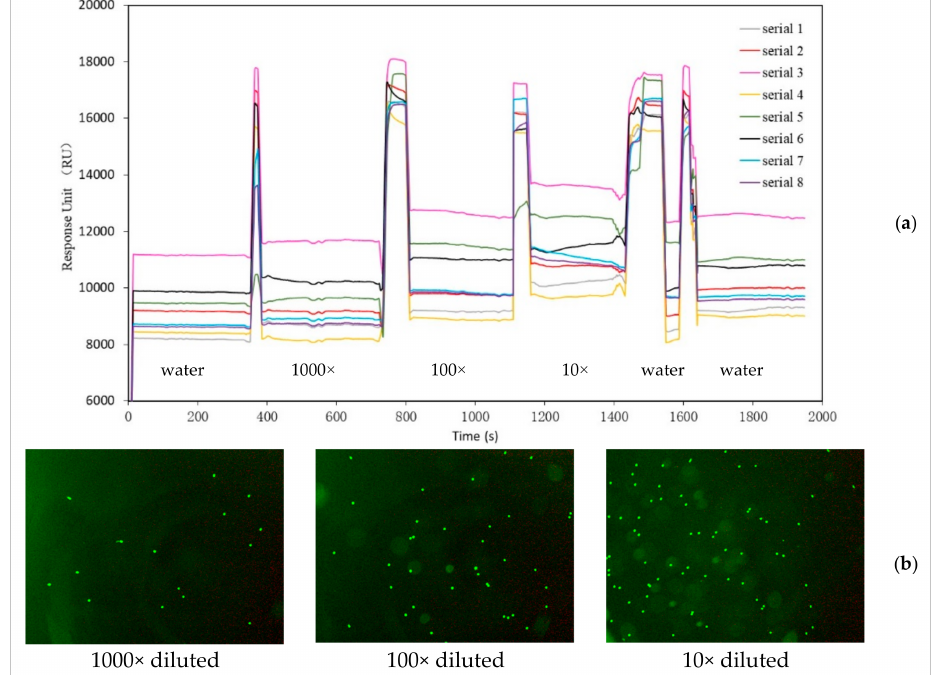
Figure 5. Monitoring of SPR signals ( a ) and fluorescence images ( b ) of fluorescent microspheres in real time with di ff erent concentrations.